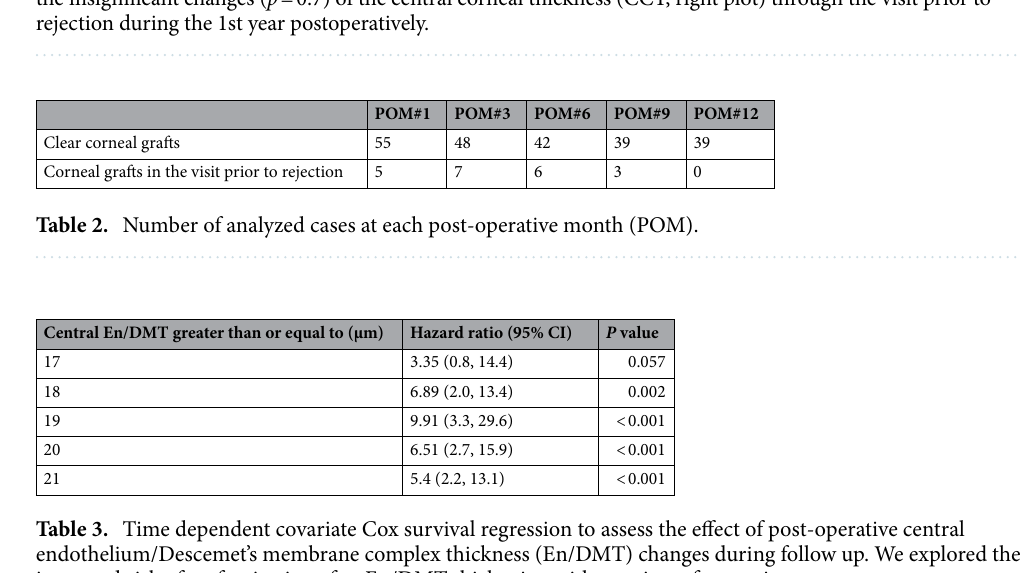
Table 3. Time dependent covariate Cox survival regression to assess the effect of post-operative central endothelium/Descemet’s membrane complex thickness (En/DMT) changes during follow up. We explored the increased risk of graft rejection after En/DMT thickening with a variety of cut-points.